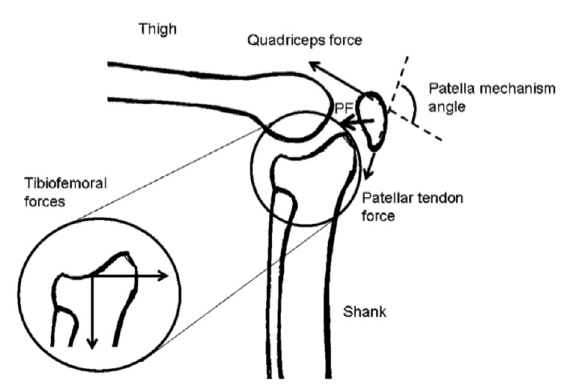
Figure 2 - Illustration of the patellofemoral joint and related forces (quadriceps, patellar tendon and patellofemoral compressive). Patella mechanism angle ( according to Matthews et al. angle = 30.46 + 0.53.knee flexion angle). Highlight of tibiofemoral shear and compressive